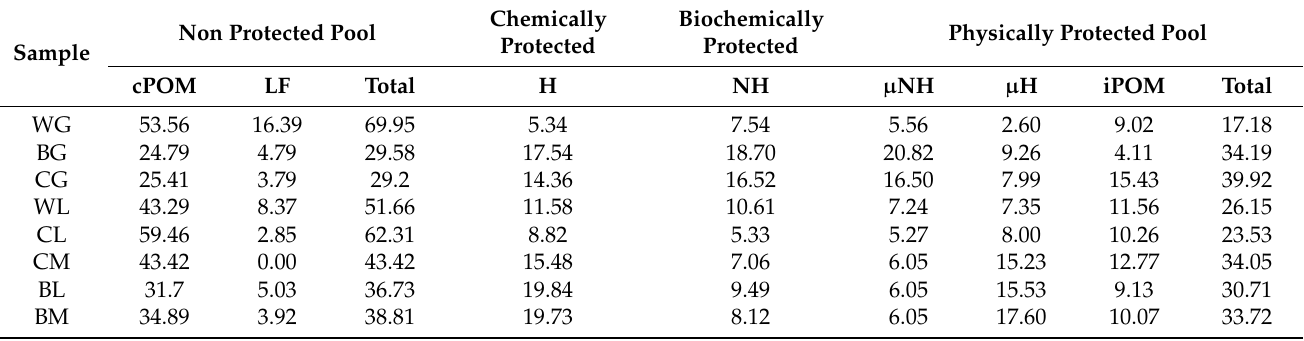
Table 5. Contribution (%) of fractions and sub-fractions to the total soil organic